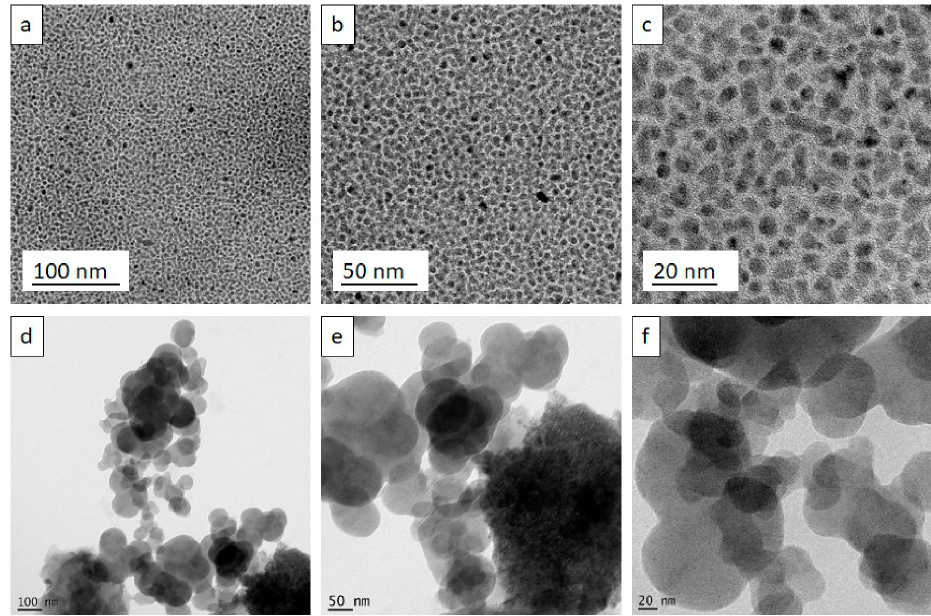
Figure 3. High-Resolution Transmission Electron Microscopical view of CNPs at ( a ). 100 nm, ( b ). 50 nm, ( c ). 20 nm and ACNPs at ( d ). 100 nm, ( e ). 50 nm, ( f ). 20 nm.